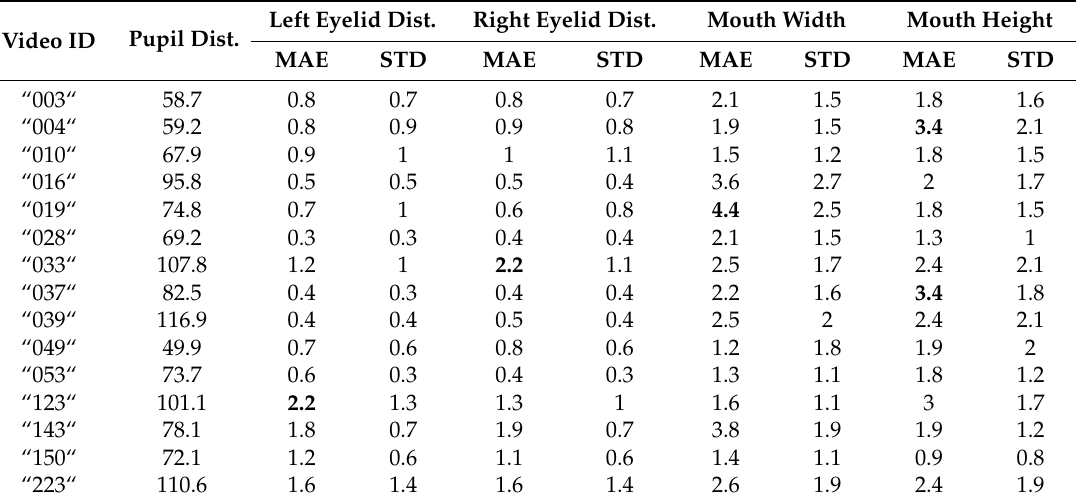
Table 3. Mean absolute error (MAE) and standard deviation (STD) of eyelid and mouth tracking on 300-VW database. (The unit is pixel.)